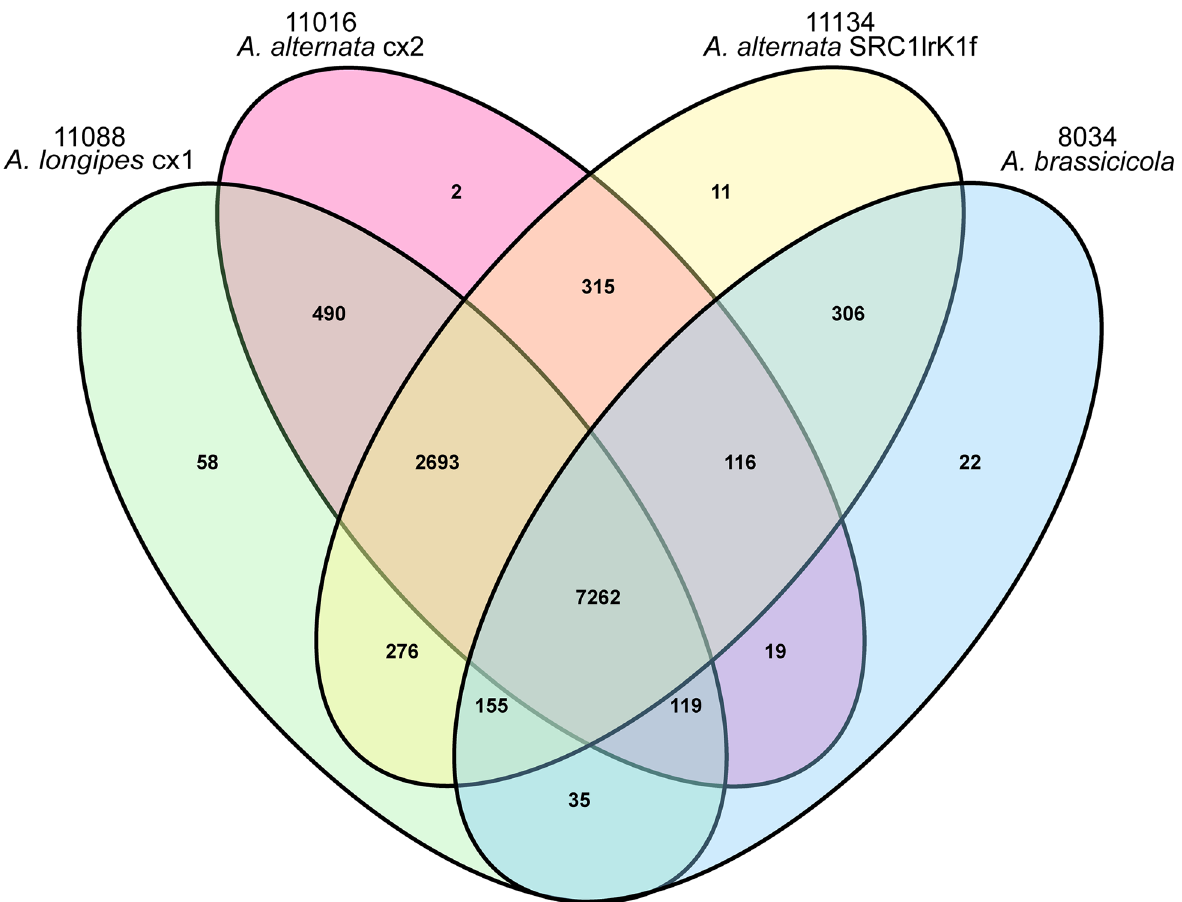
Fig 6. Venn diagram showing the number of unique and shared gene families among A . longipes cx1, A . alternata cx2, A . brassicicola and A . alternata SRC1lrK1f.